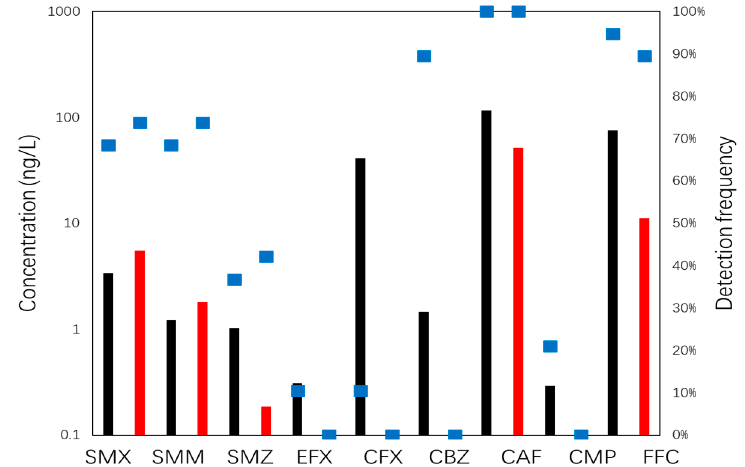
Figure 2. The average concentration (column) and detection frequencies (blue points) of detected PPCPs in the river during the wet (black column) and dry (red column) seasons. Table 2. ( a ) The descriptive analysis of overall PPCP concentration data of the Lianjiang River in the dry season; PPCP concentration is given in ng L − 1 . ( b ) The descriptive analysis of overall PPCP concentration data of the Lianjiang River in the wet season; PPCP concentration is given in ng L − 1